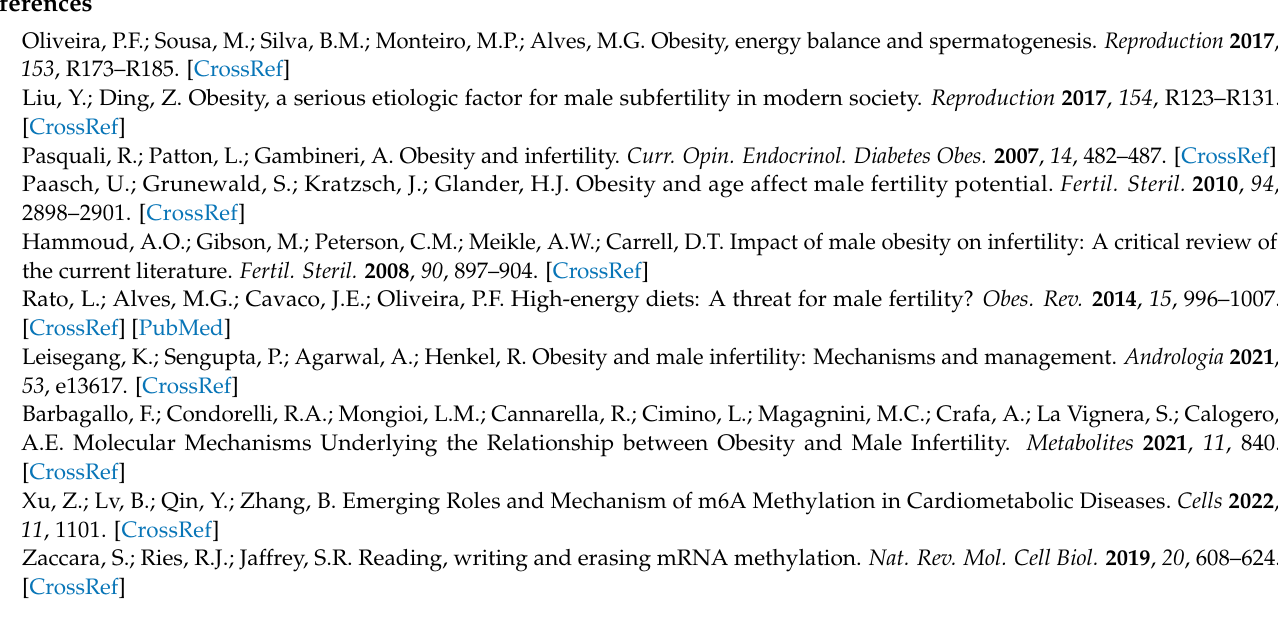
Table S2: HIIT protocol over 8 weeks; Table S3: Primer sequences used for